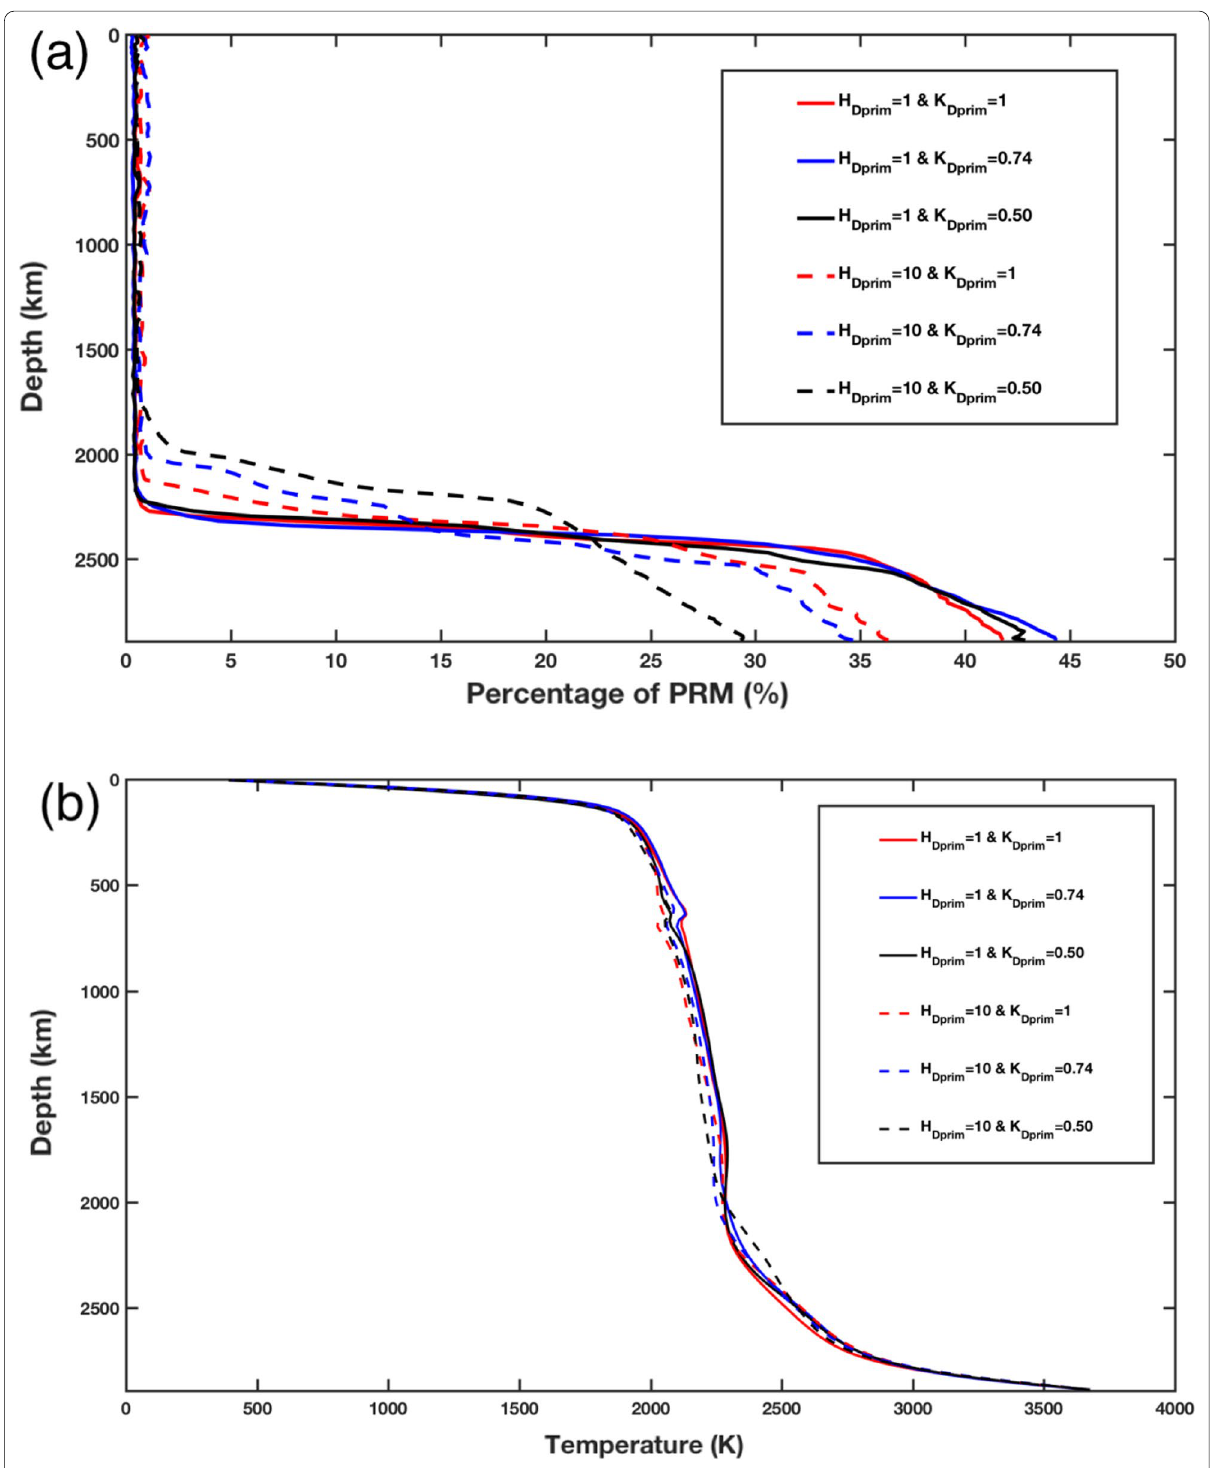
Fig. 3 a 1‑D profiles of distributions of primordial material with depth at t t 4.5 =